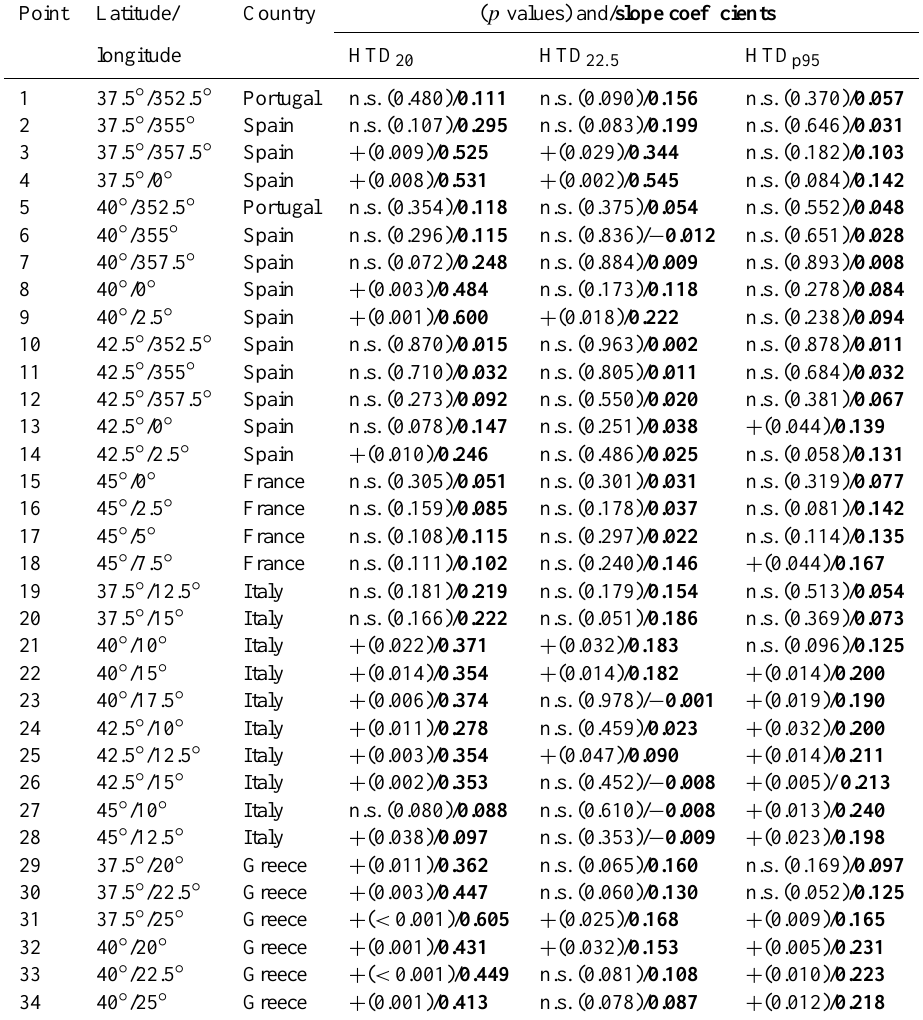
Table 1. Simple linear regression analysis of significant trends in annual number of HTD p95 , HTD 20 , and HTD 22 . 5 over time in the study area during the June–September period from 1978 to 2012. Point locations are mapped in Fig.